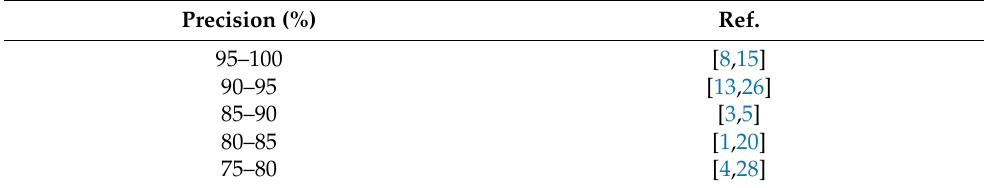
Table 5. Performance (precision) analysis of the various crack detection